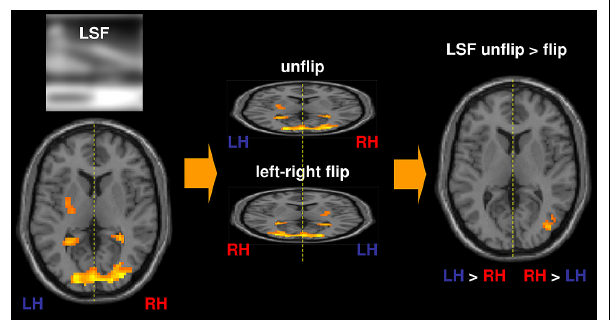
FIGURE 3 | Method of direct inter-hemispheric comparison. Two sets of functional volumes, obtained from functional scans, are compared at individual level. One set is represented by functional volumes in accordance with neurological convention (the left hemisphere – LH appears on the left side of images) and the other set is represented by the same functional volumes this time in accordance with radiological convention (the right hemisphere – RH appears on the left side of images). Images from the second set were “flipped” by 180 ◦ in the midsagital plane, thus providing “mirror” images of the first set. Contrasts between “unflipped” and “left-right flipped” images were then calculated for each of the spatial frequency components of natural scenes. In order to assess hemispheric predominance during the perception of LSF scenes, for instance, the following contrast was calculated: LSF unflip > flip. Regions which were more highly activated in the left hemisphere than in the right hemisphere appear on the left side, and regions which were statistically more highly activated in the right hemisphere than in the left hemisphere appear on the right